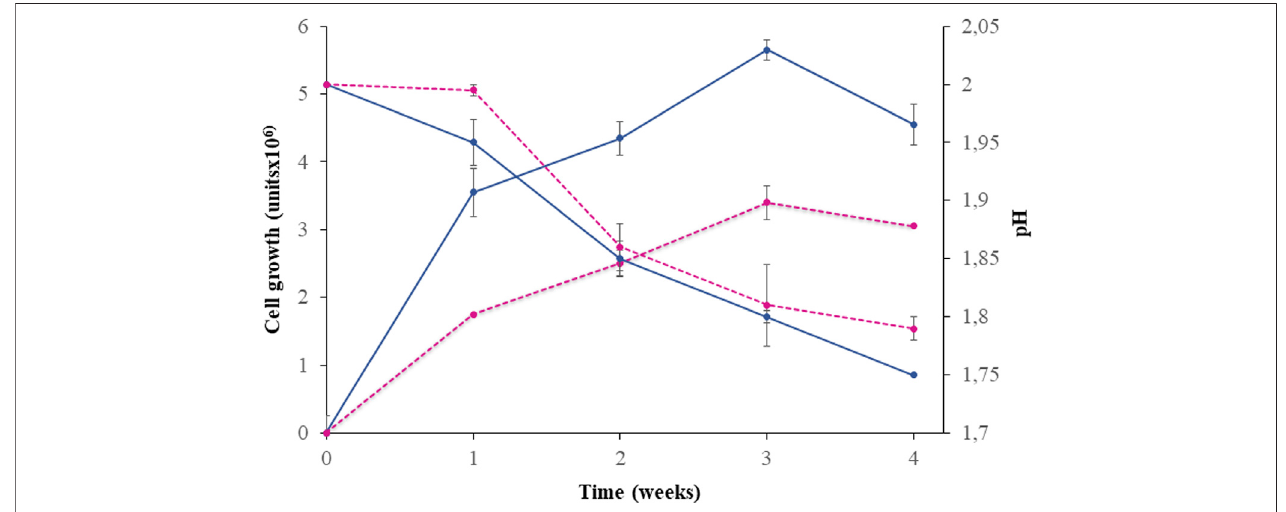
FIGURE 1 | Growth of A. ferrooxidans (A) and pH variation (B) in shake fl asks over 4 weeks. The cultivation medium was the modi fi ed 9K medium supplemented with1%w/w rubberparticles (solid line) ,andwithoutrubberparticles (dashed line) .Measurementsweredoneinduplicates andthestandarderrorispresented inthe fi gure.